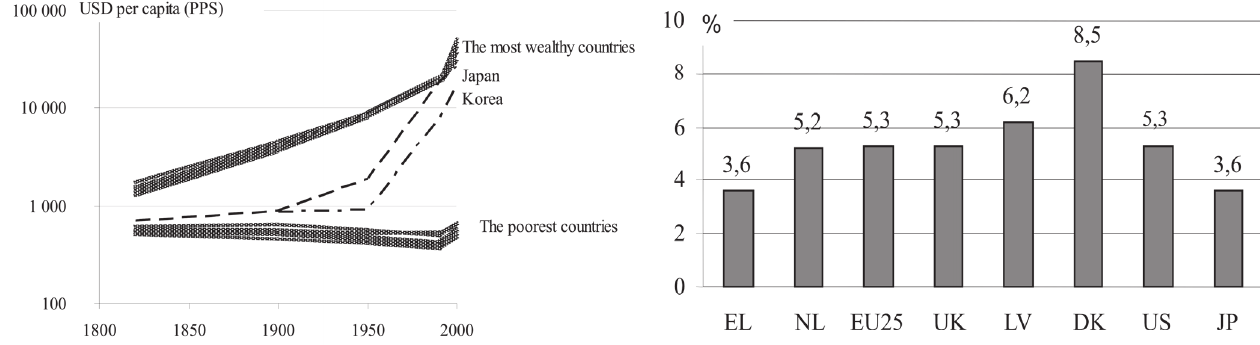
Fig 4 . Public expenditure on education as percentage of GDP